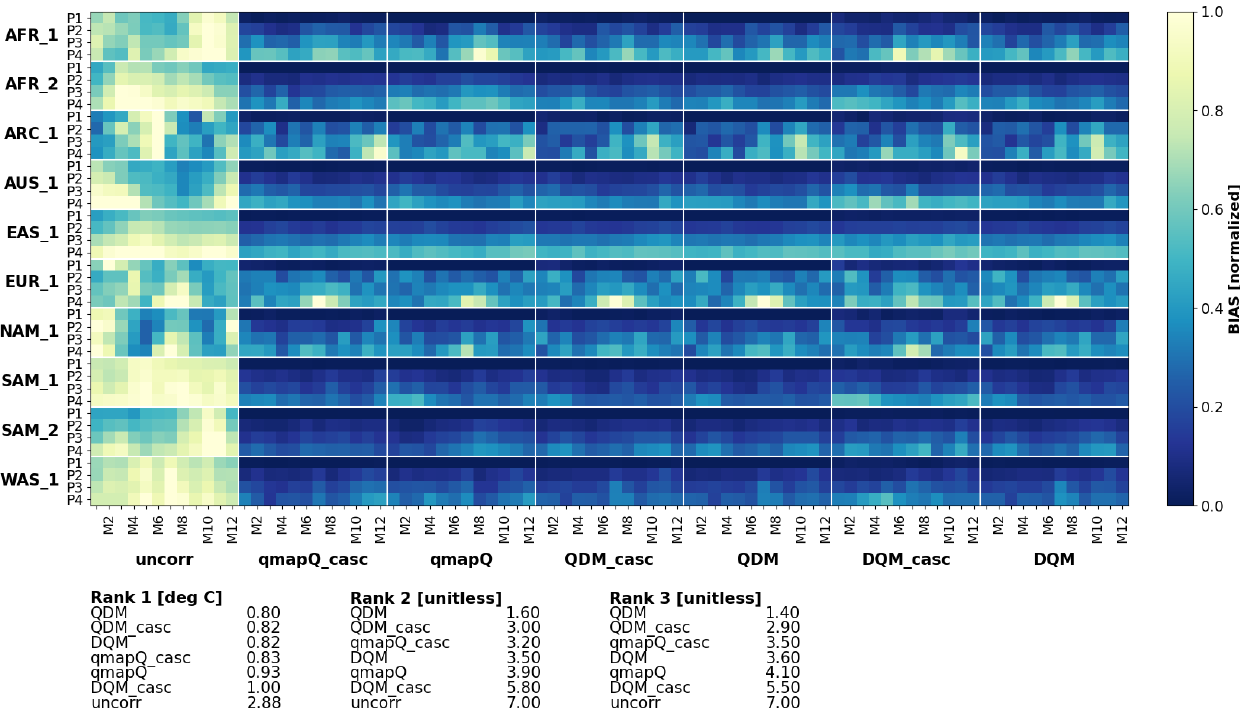
Figure 5. The same as Fig. 4 but for mean